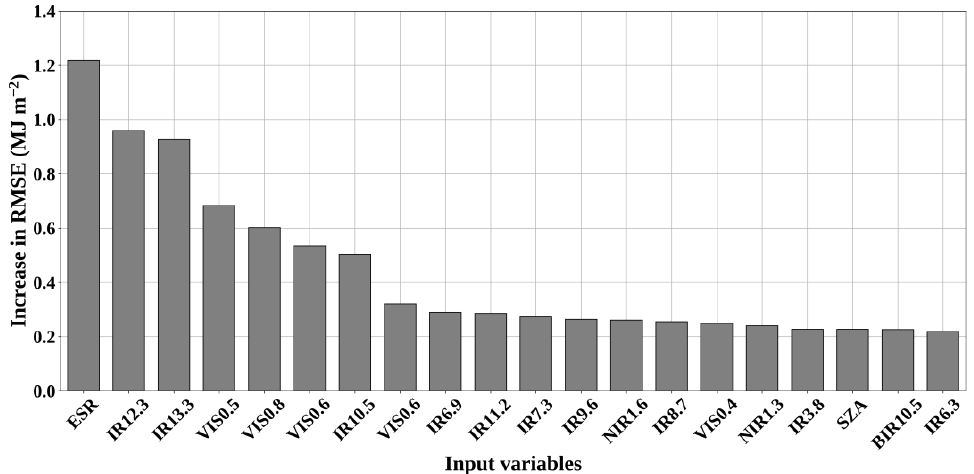
Figure 11. Feature permutation of the trained CNN model, with feature permutation ranked by the increase in the RMSE of GK2A/AMI-derived SSI. increase in the RMSE of GK2A/AMI-derived